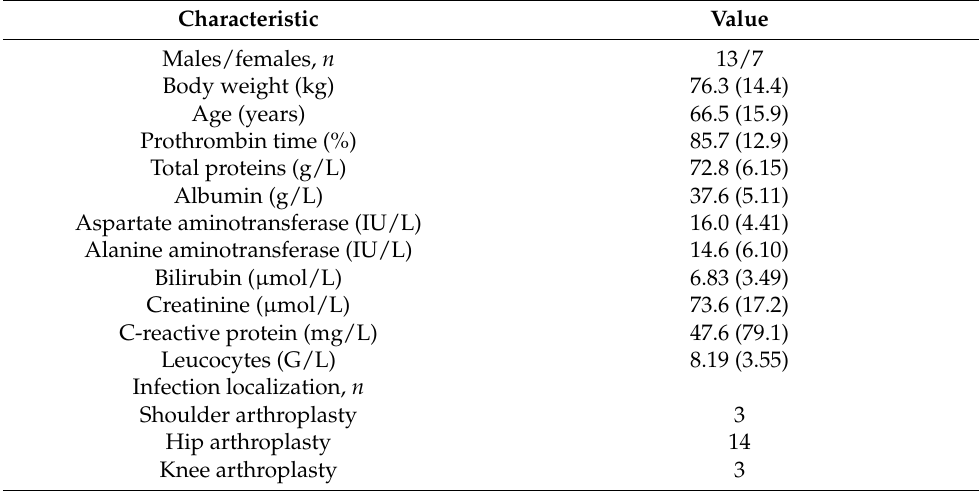
Table 1. Characteristics of the 20 patients treated with clindamycin for chronic prosthetic joint infections.